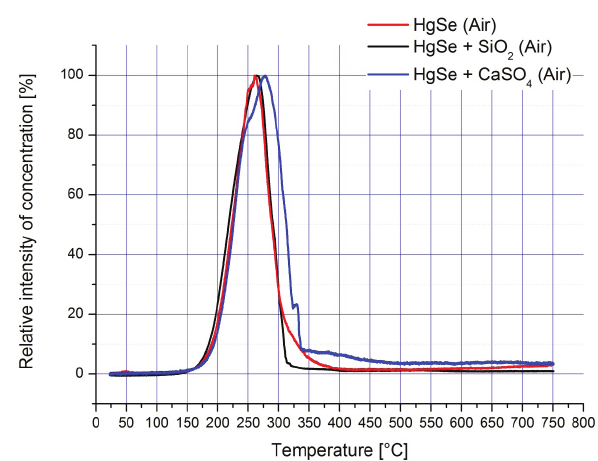
Figure 17: Thermograms of HgSe, purged with nitrogen.